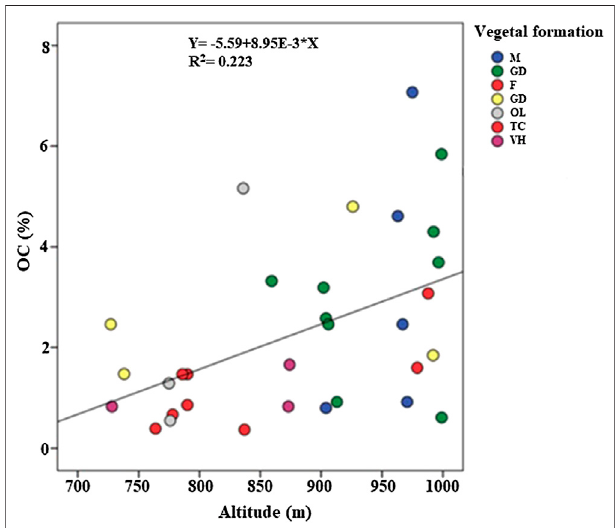
FIGURE 1 | Correlation between altitude and soil organic carbon. M: matorral; GC: sparse garrigue; F: forest; GD: dense garrigue; OL: olive grove; TC: Oak coppice; VH: Herbaceous vegetation.